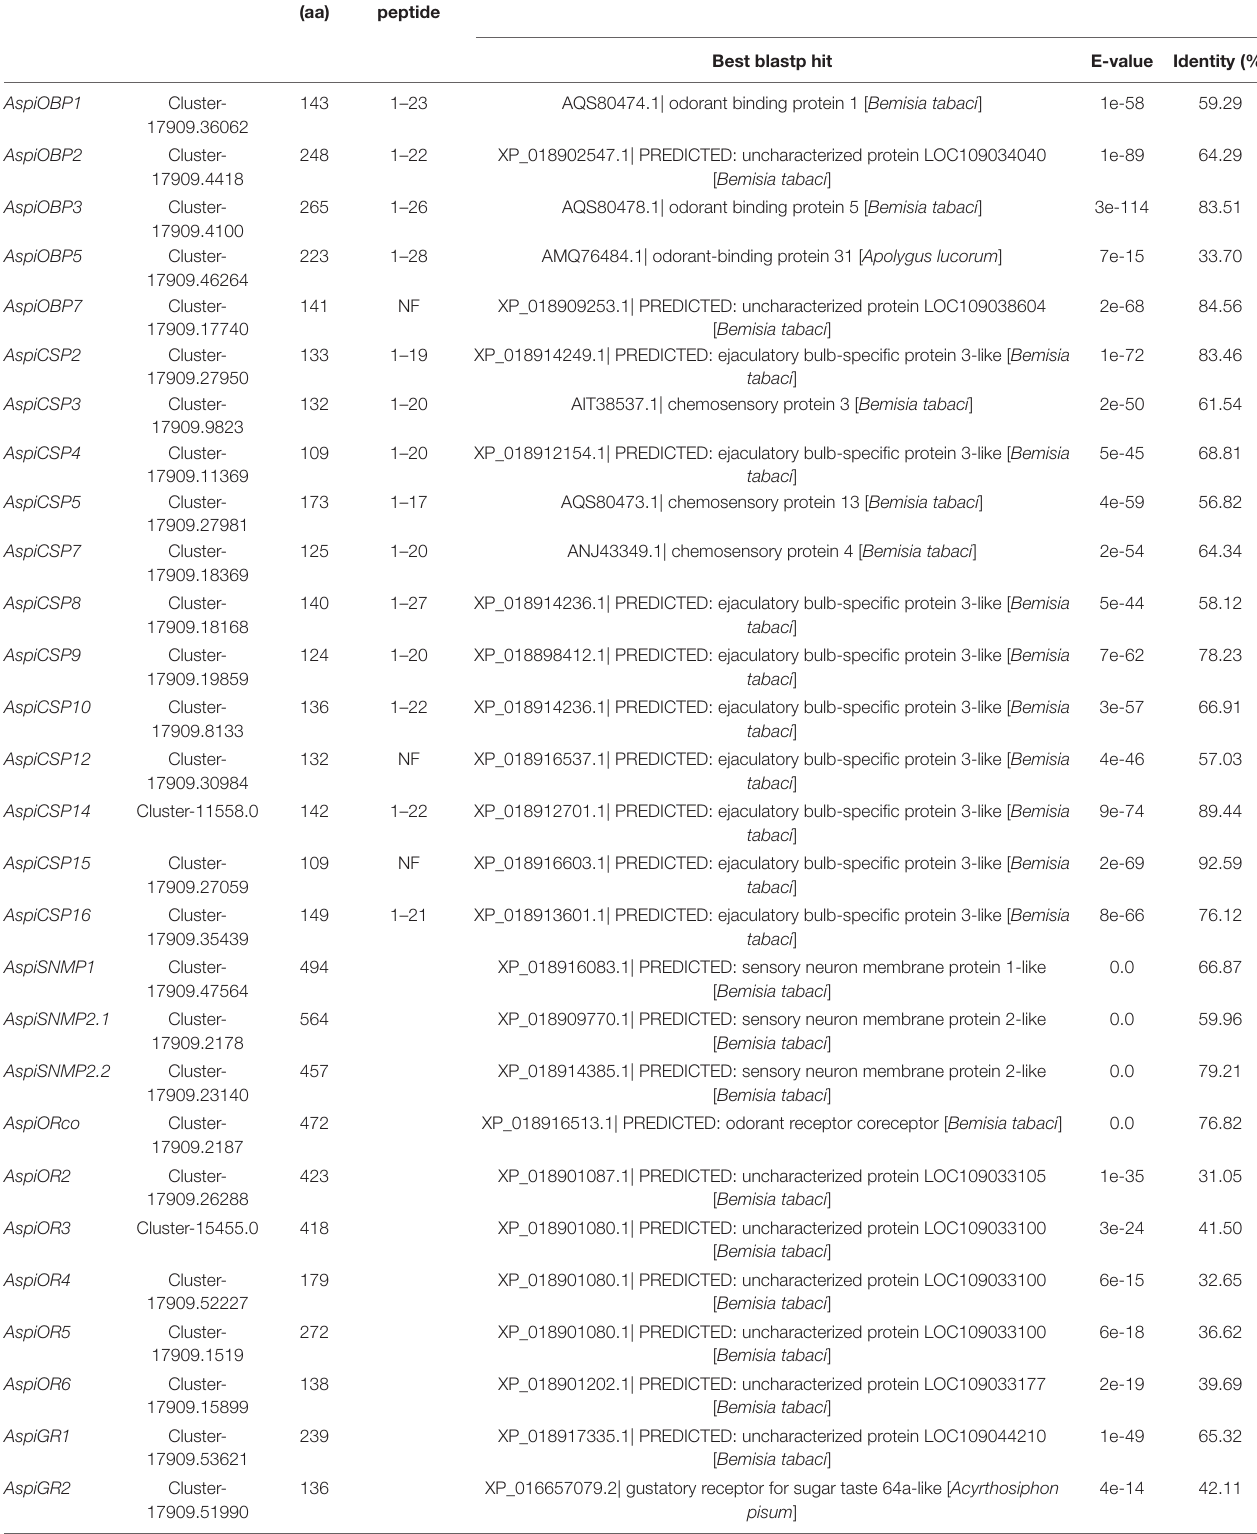
TABLE 3 | Candidate chemosensory genes in A. spiniferus